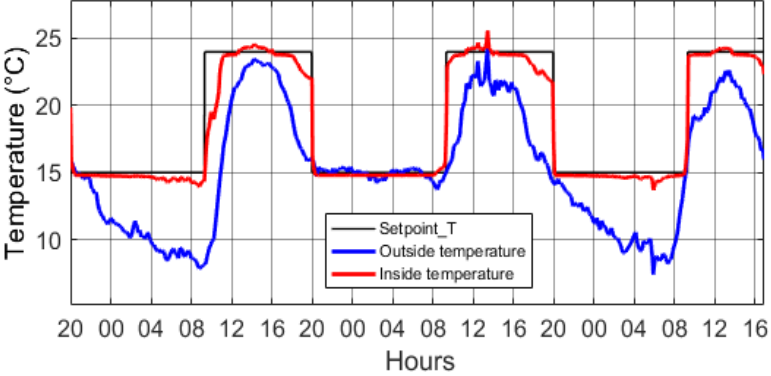
Figure 14. Simulation results for greenhouse temperature under fuzzy control.